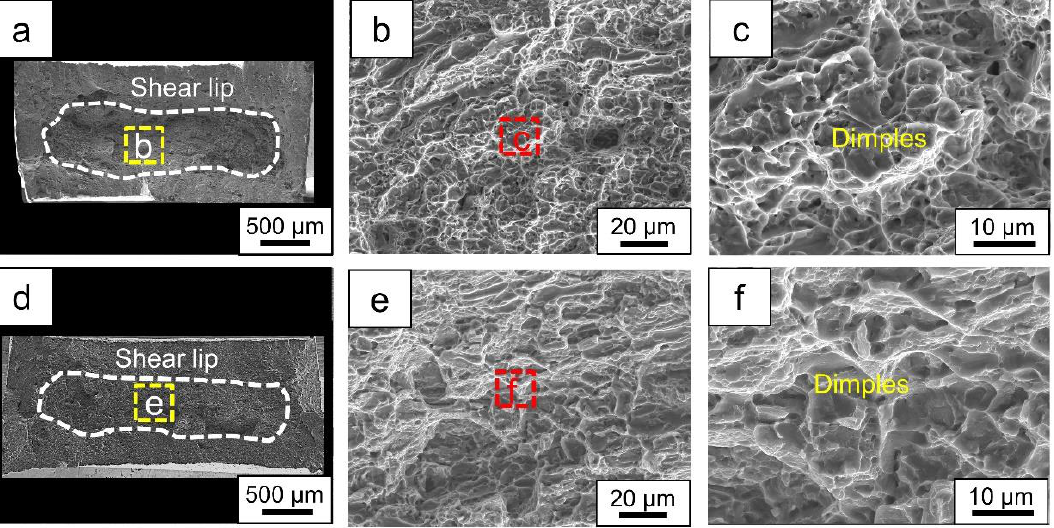
Figure 9. Fracture surface features of the fractured LD-Ti423 alloy with different magnifications. Red and yellow dashed rectangles represent areas characterized with larger magnification. ( a – c ) HR condition; ( d – f ) HR+STA condition.